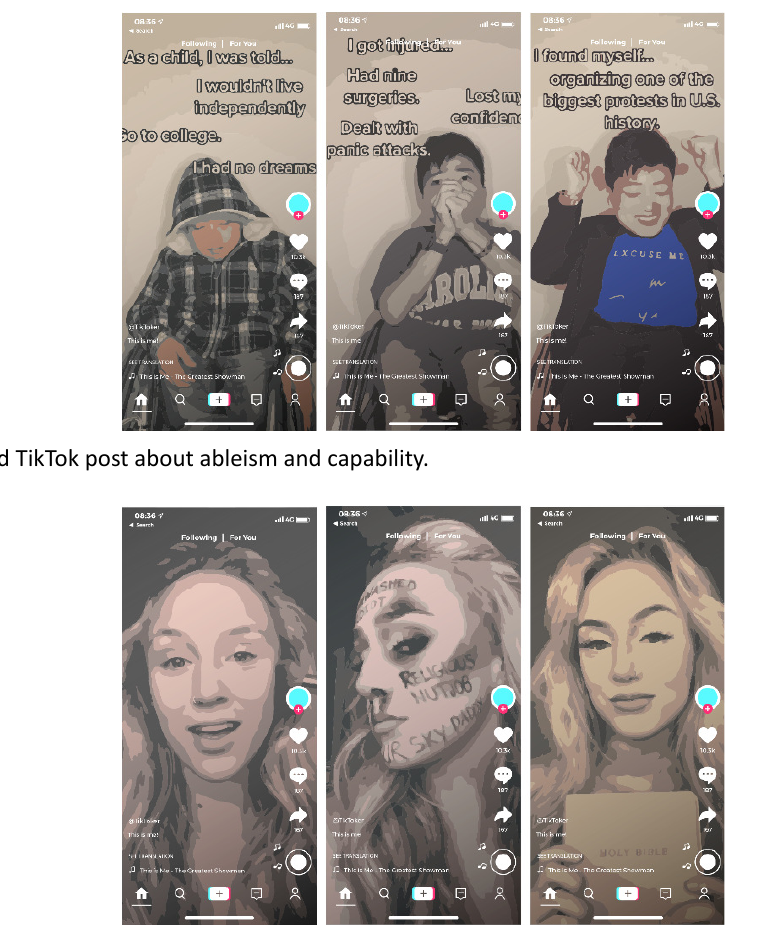
Figure 8. Illustrated TikTok post about religion and